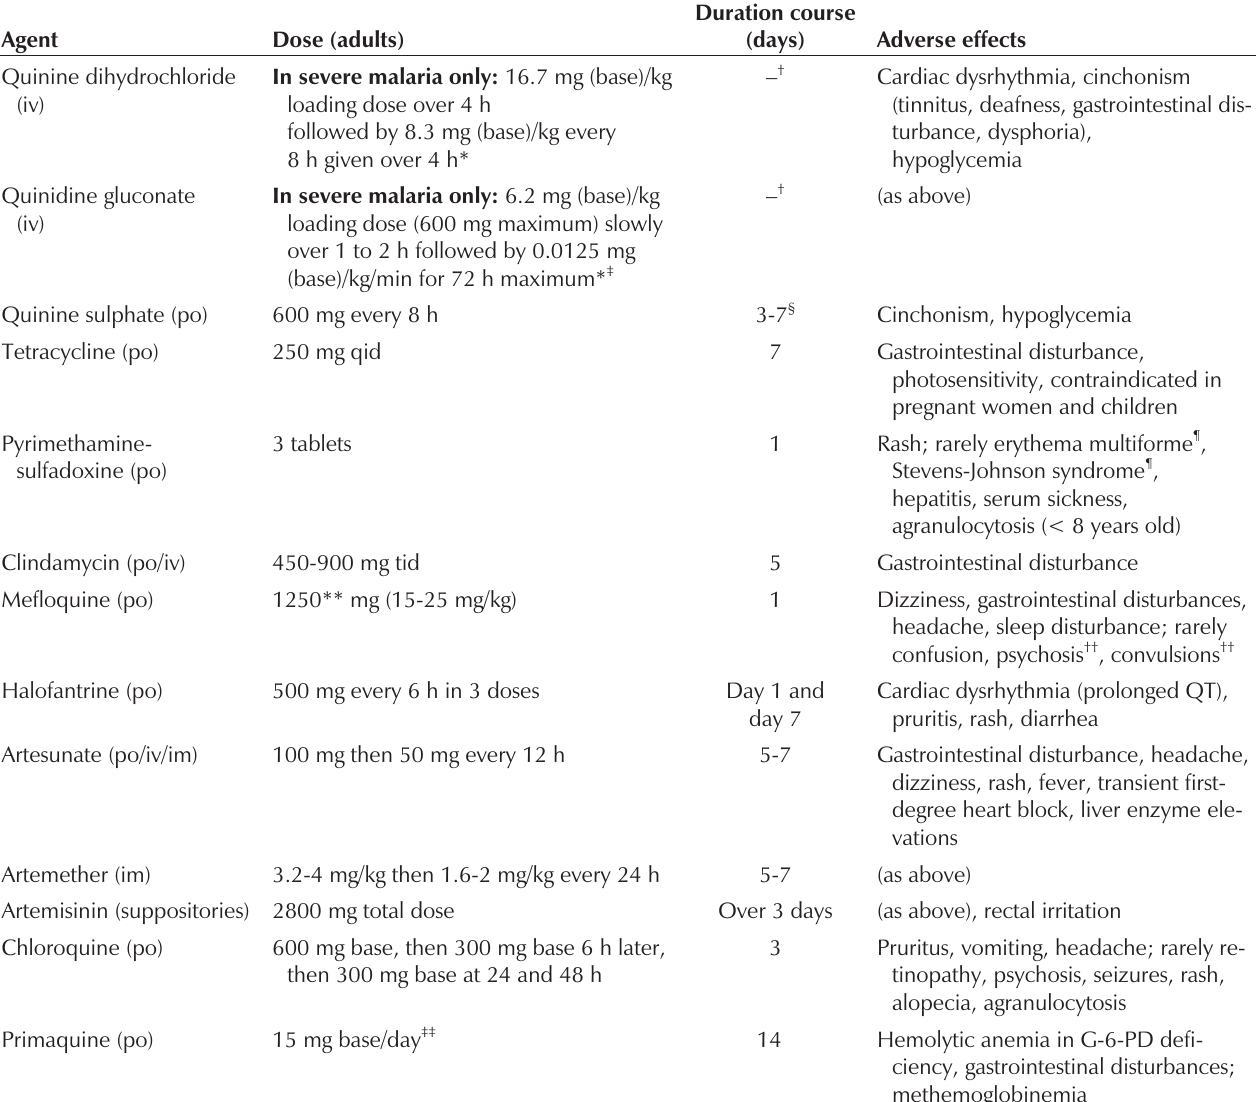
Chemotherapeutic agents for malaria Agent Dose (adults)